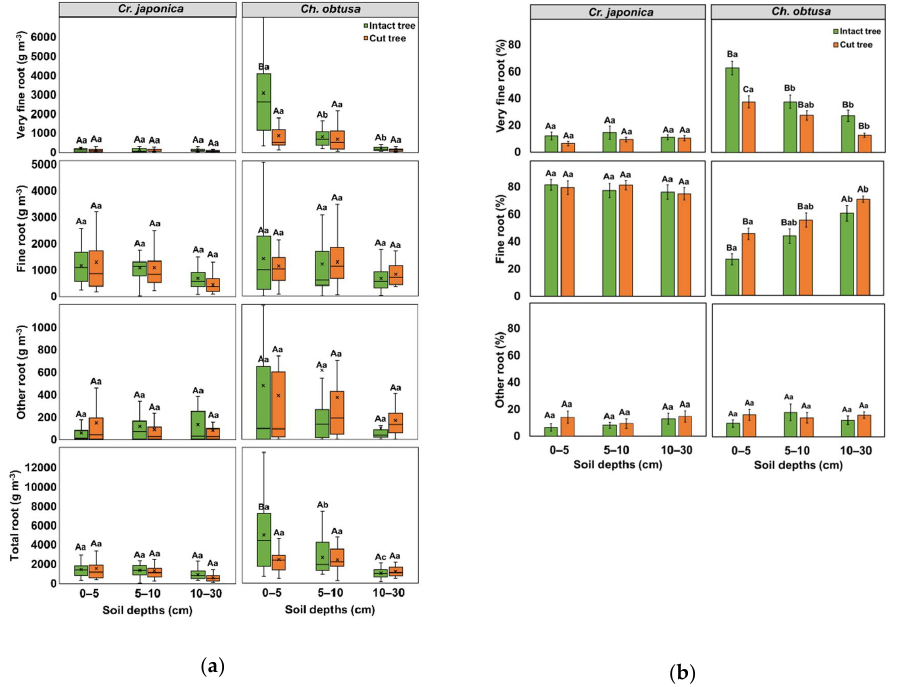
Figure 2. Root biomass density (g m −3 ) at different soil depths of Cryptomeria japonica and Chamaecyparis obtusa intact tree and cut tree plots. ( a ) Root (very fine, fine, other, and total) biomass density; ( b ) Root (very fine, fine, and other) biomass density percentage to total root biomass density. Capital and small letters denote significant differences between plots and different soil depths, respectively ( n = 20). Root biomass density data were retrieved from [18]. respectively ( n = 20). Root biomass density data were retrieved from